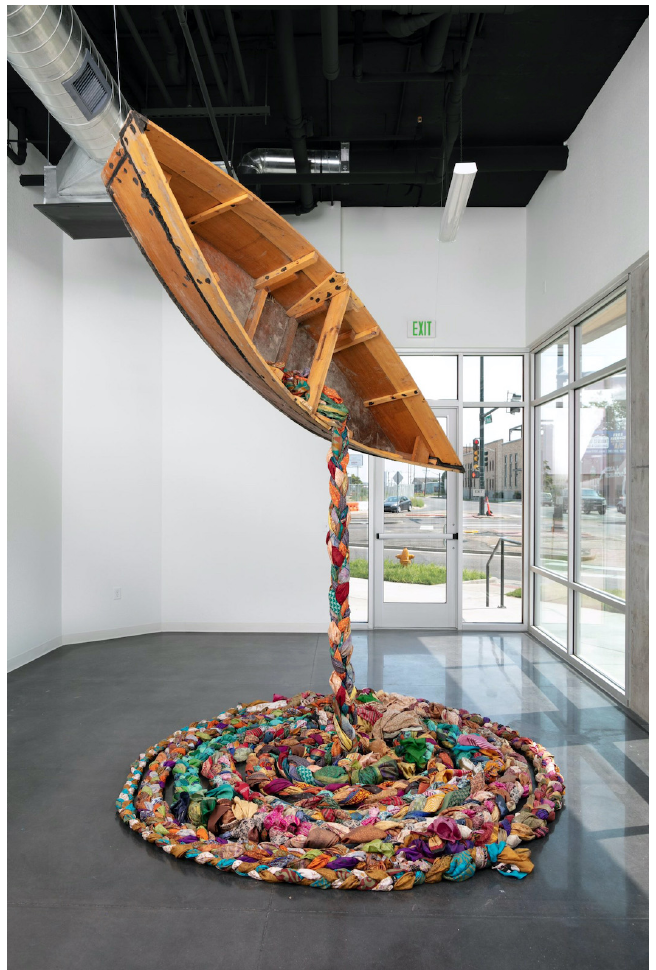
Figure 9. Suchitra Mattai, Life-Line , 2020, vintage saris, found boat, 12 × 10 feet (K Contemporary). Mattai’s sari works form a prolific body of work that significantly underscores the artist’s concern for the movements of peoples, starting with her own family’s crossings of the k¯al¯a p¯an¯ı and, expansively, those of the indentured. In the absence of architectural monuments for those lost, physically and metaphorically, to the kala pani, Mattai’s large-scale sari works stand in as monuments to honor all that has been lost. “Making a very large tapestry was an ode, a monumental ode, to those people,” she offers 15 . Beyond her personal-political response to the k¯al¯a p¯an¯ı, Mattai simultaneously engages with